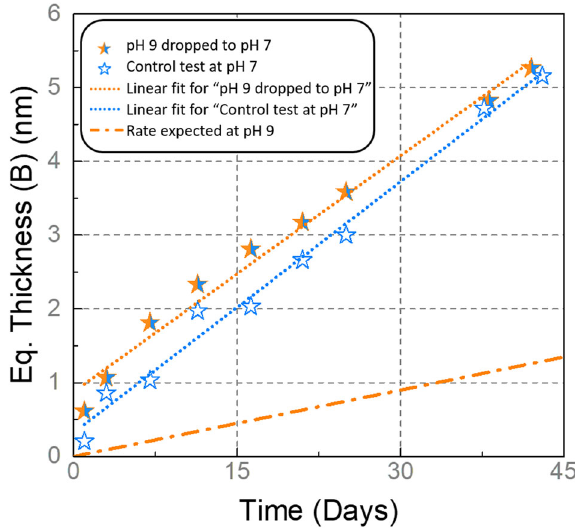
Fig. 3 Effect of a decrease in pH on ISG samples altered for 6 yr at pH 9. Equivalent thickness of altered glass calculated from B released during a 43-day immersion at pH 7, and comparison to a control test. B concentrations in Experiment 2 are measured with a better accuracy than in Experiment 1 because leachates are free of K and analyses are conducted by ICP-MS which offers a low detection